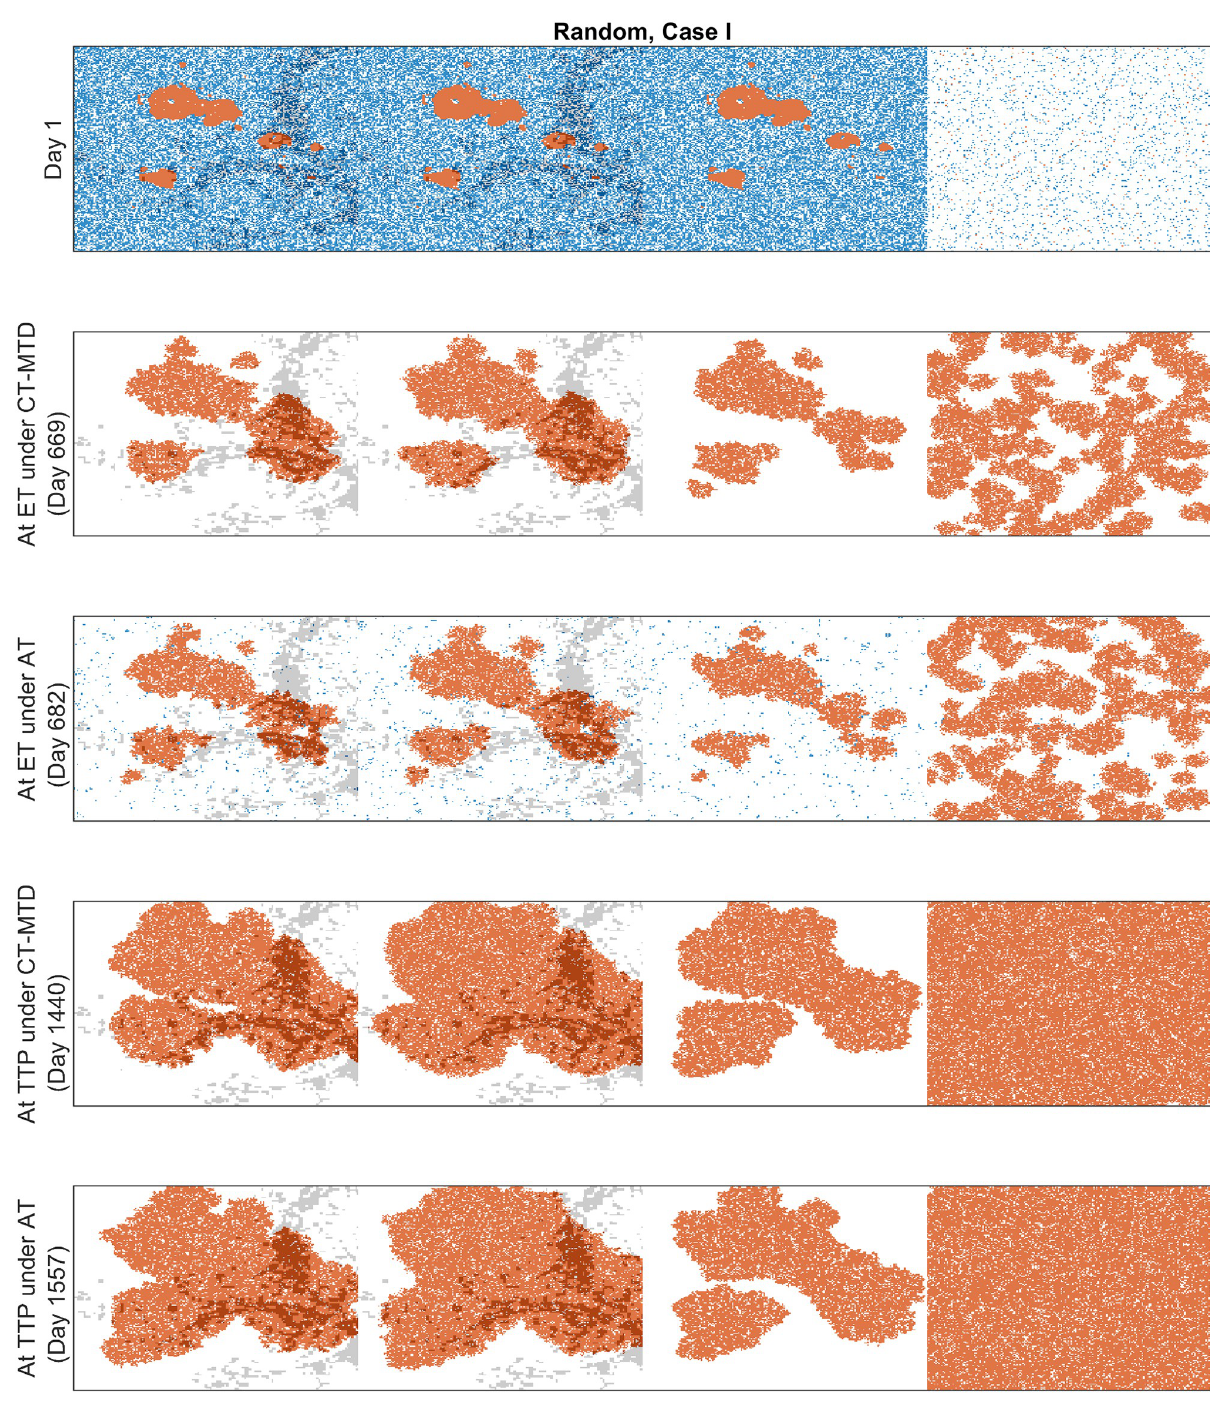
Fig 16. Cell configurations at the ET and TTP under CT-MTD and AT for Case I with the random invisible metastasis. The red, blue, and white dots correspond to R-cells, S-cells, and empty sites. The gray dots show the sites that are accompanied by fibroblasts.